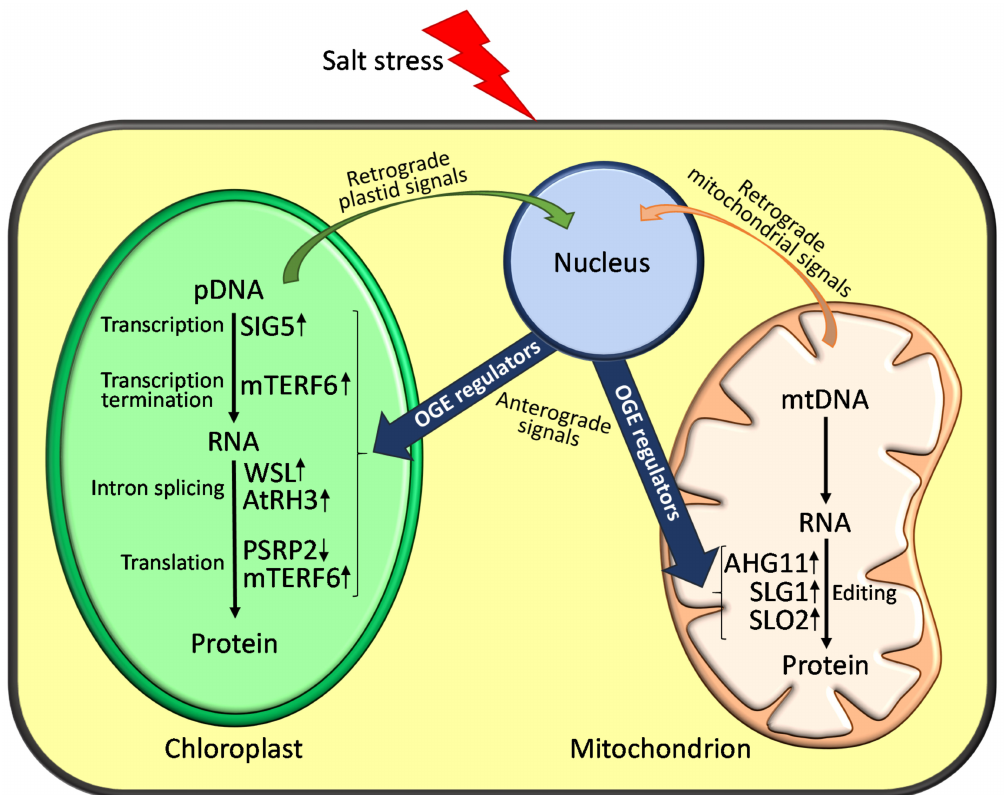
Figure 1. Schematic representation of the cellular functions of OGE regulators in plant response to salinity. Salt stress can perturb chloroplast or mitochondrion homeostasis and this would be communicated to the nucleus through retrograde signals, leading to changes in nuclear gene expression. In turn, this would activate the expression of OGE regulators (e.g., mTERFs, PPRs or DEAD-box RHs proteins), which would result in anterograde signalling responses to adjust organellar function to salinity. In the figure, inside a mitochondrion (purple) and chloroplast (green), only those molecularly-characterized OGE regulators whose mutations lead to altered responses to salinity are depicted. The OGE processes affected in these mutants, as well as their enhanced ( ↑ ) or reduced ( ↓ ) sensitivity to salt stress, are shown (see also Table 1 for further